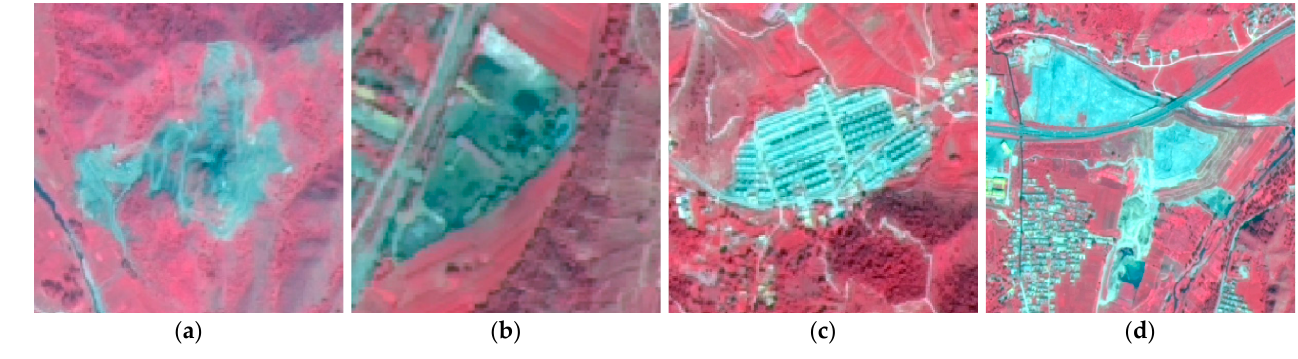
Figure 17. Some misidenti fi ed cases. ( a ) Bare soil , ( b ) factory, ( c ) residential area, ( d ) service